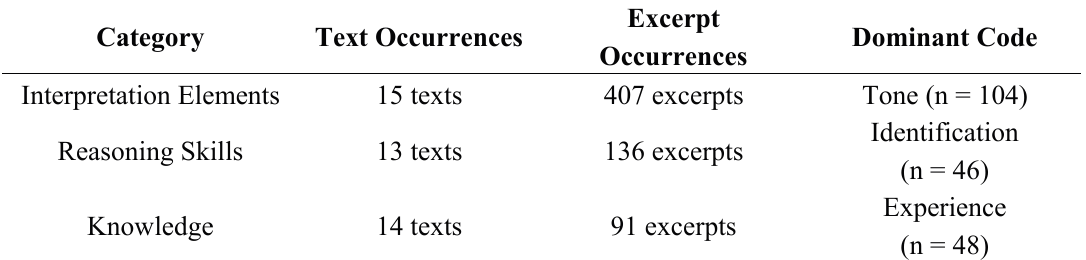
Table 5. Summary of the coding process. For each of the three main categories, the numbers in which its codes occur, the total number of excerpts assigned to that category, and the dominant code are